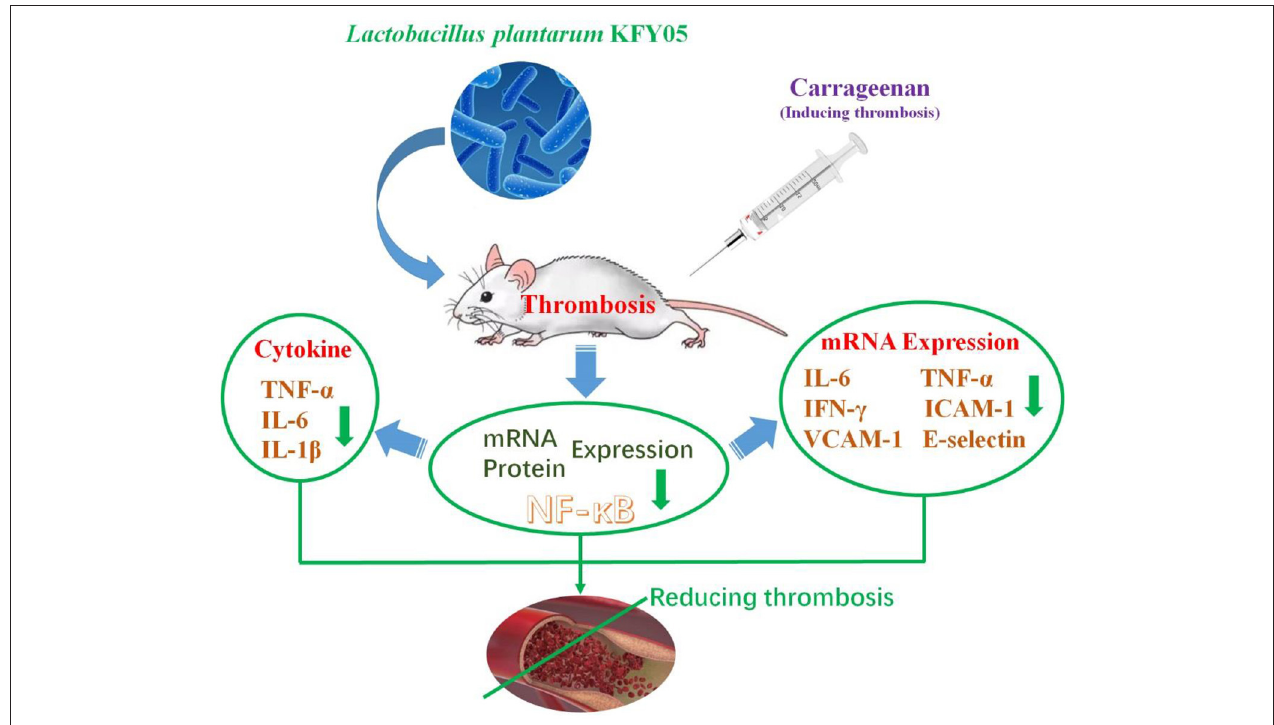
FIGURE 10 | Schematic diagram of the mechanism of Lactobacillus plantarum HFY05 on thrombosis by regulating inflammatory response.